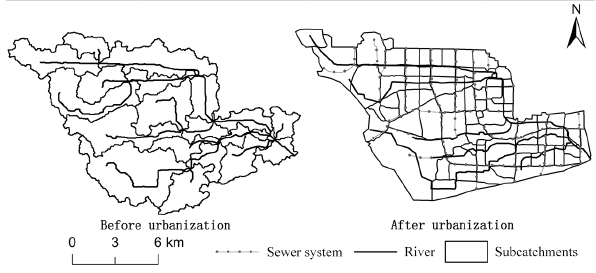
Figure 3. Model development in different urbanization